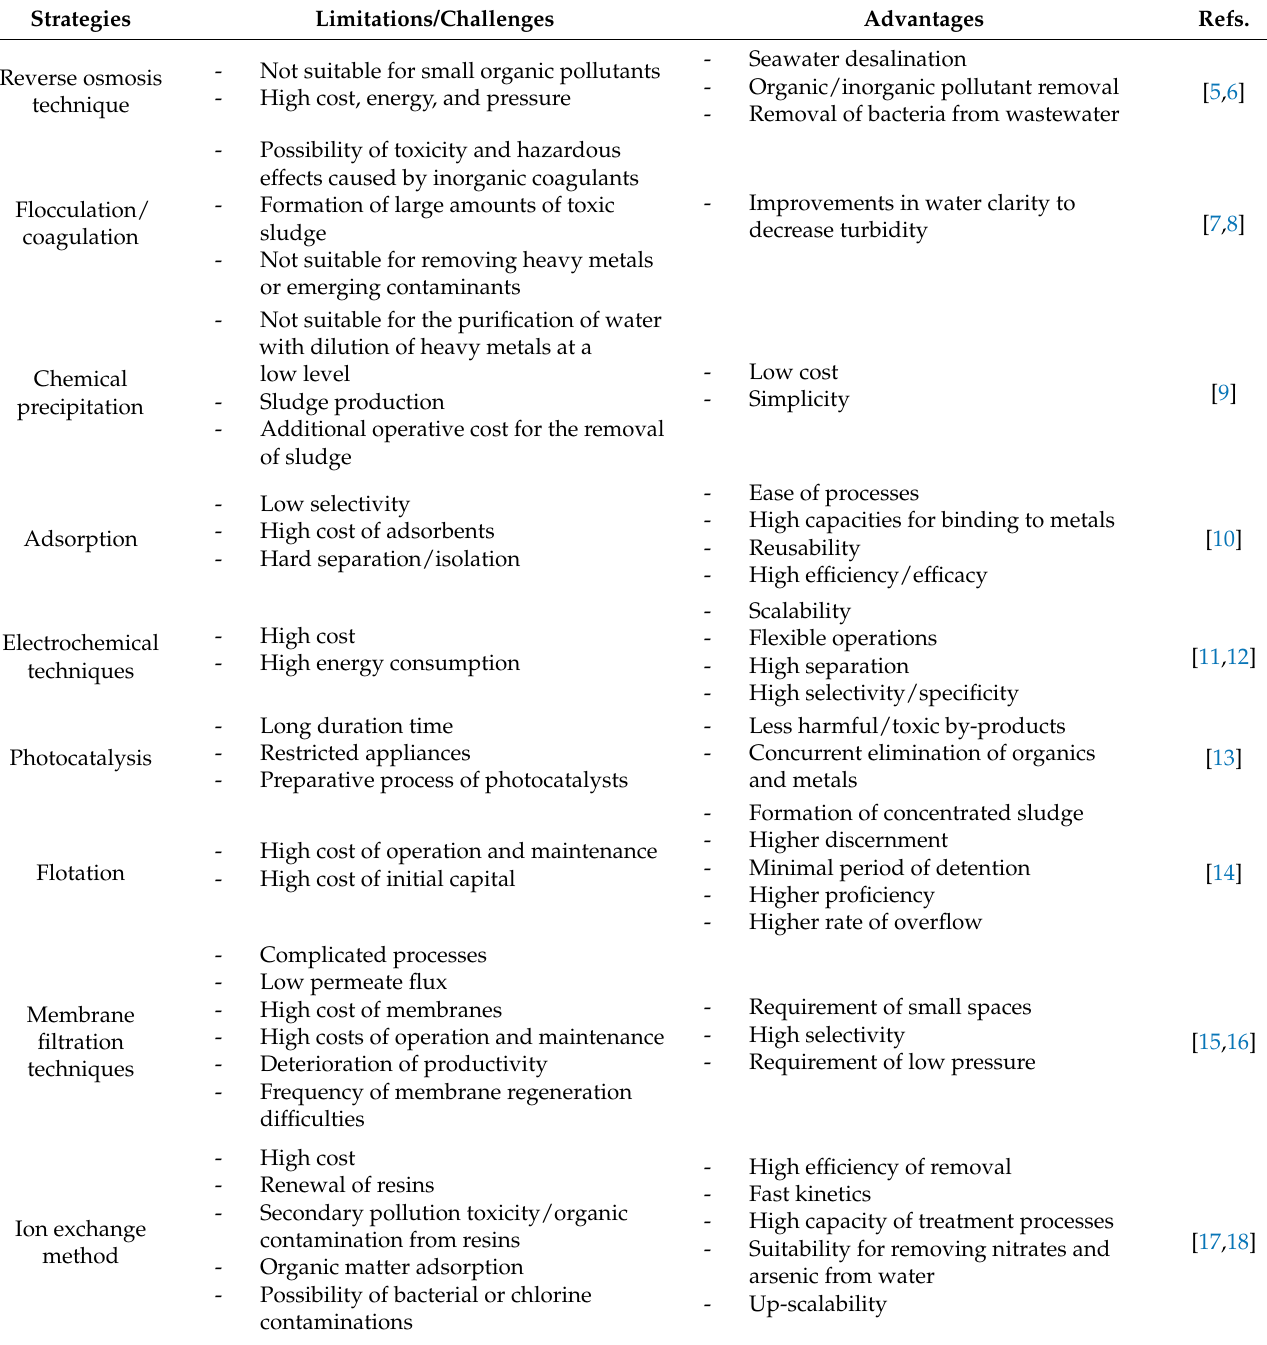
Table 1. Some salient advantages and limitations of water treatment